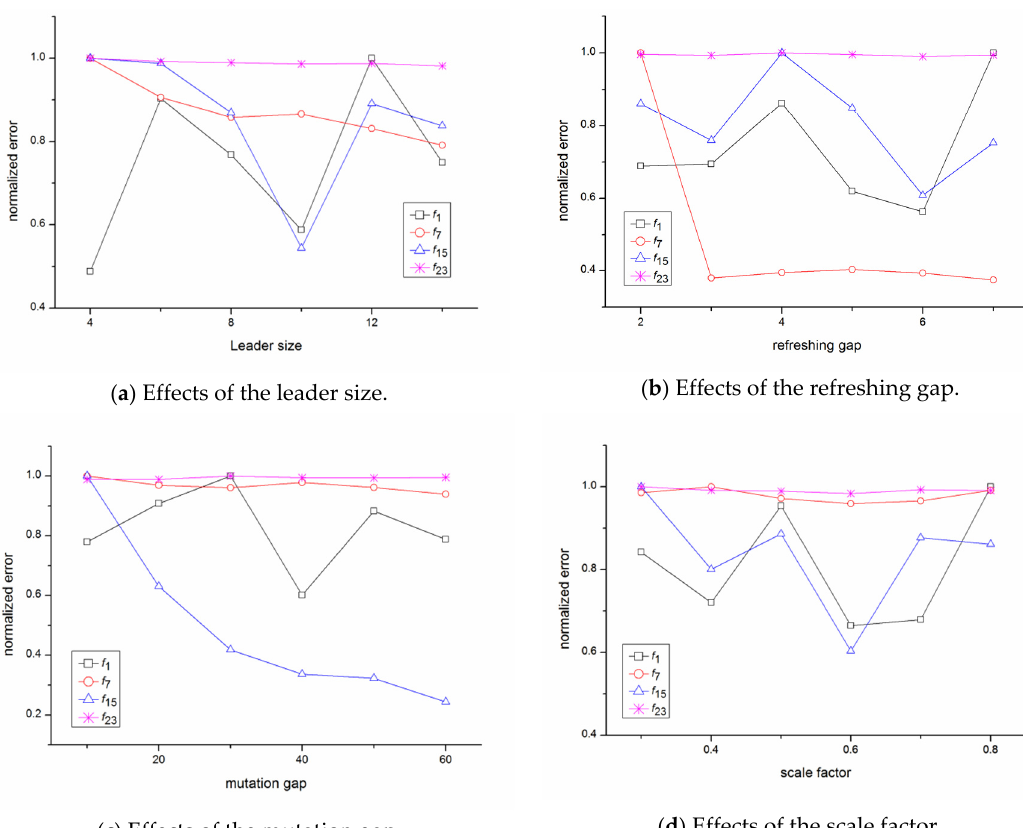
Figure 3. Effects of parameter settings.